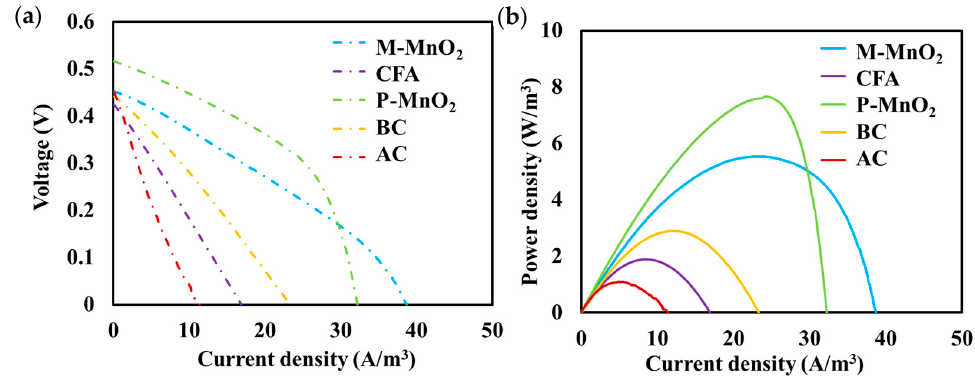
Figure 6. MFC voltage Ucell ( a ) and power density ( b ) versus current density for the different cathode strategies (P-MnO 2 , M-MnO 2 , CFA, BC,